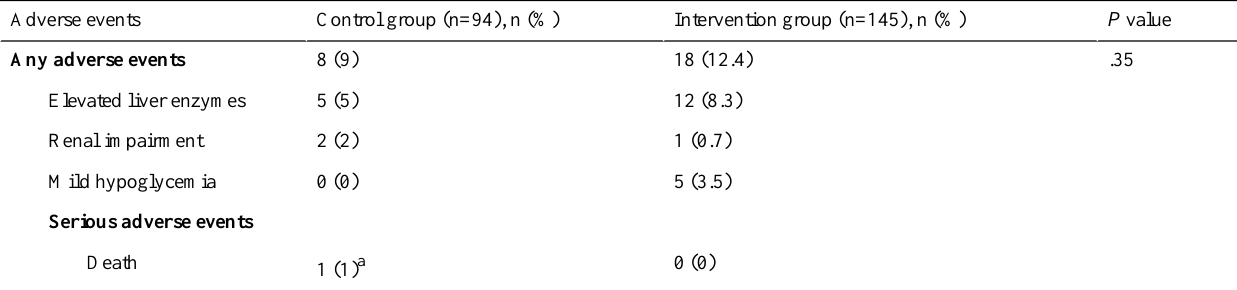
Table 3. Adverse events through 3